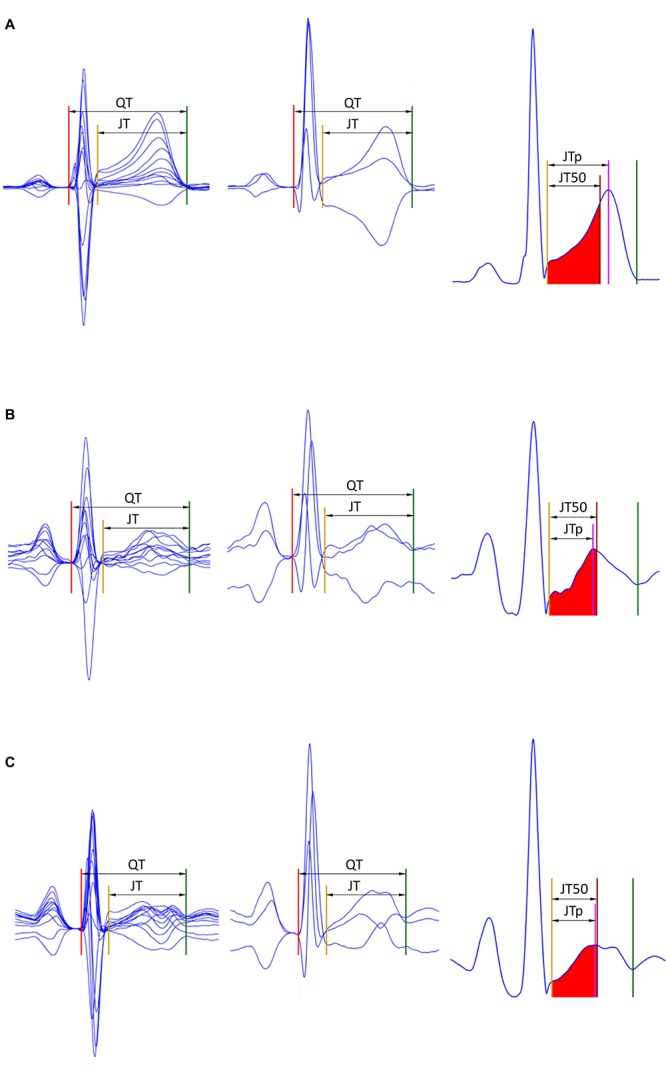
Examples of the JTp and JT50 measurements. The rows (A–C) of to three different ECG recordings made in a male (32 years), female (22 years), and female (42 years), respectively. The underlying heart rates were 68, 95, and 96 beats per minute, respectively. In the left panels, representative P-QRS-T complexes are shown for all 12 leads superimposed on the same isoelectric axis, the middle panels show derived orthogonal XYZ leads also on the same isoelectric axis, and the right panels show the vector magnitude of the orthogonal XYZ leads. The horizontal (time) scale of all the panels is the same. The red, yellow, and green lines show the positions of the QRS onset, QRS offset, and T offset points. In the left panels, the violet line shows the T wave peak while the red-filled area (between the yellow and brown lines) is the first middle of the area under the T wave representation (i.e., the brown line divides the area under the T wave between the yellow and green lines into two equal halves). Measurements of the JTp and JT50 intervals are shown in the left panels. Note that JTp > JT50 in panel (A) while JTp < JT50 in panels (B,C) albeit the difference between JTp and JT50 is minimal in panel (C). Note also that in all three cases, the position of the peak of the T wave is different in different 12 leads as well as in different orthogonal leads.